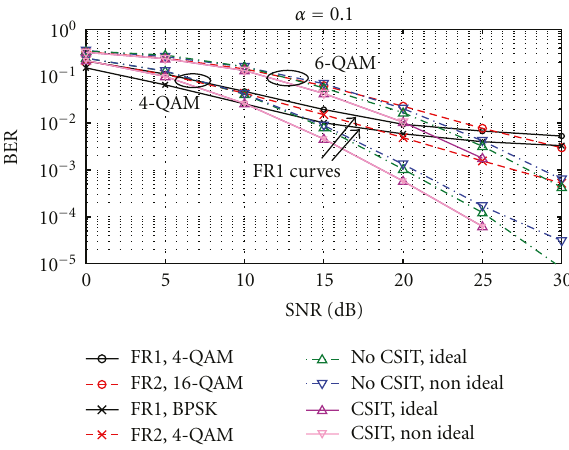
Figure 2: Bit error rate (BER), as a function of the SNR (dB), for two isolated base stations. The link quality α = 0 . 1, and the mod- ulation is4-QAM and 16-QAM, respectively. The FR1 curves denote the direct transmissionscheme with BPSK and 4-QAM modulation, respectively. The non ideal link denotes the case when the base station-to-base station link gain is β = α